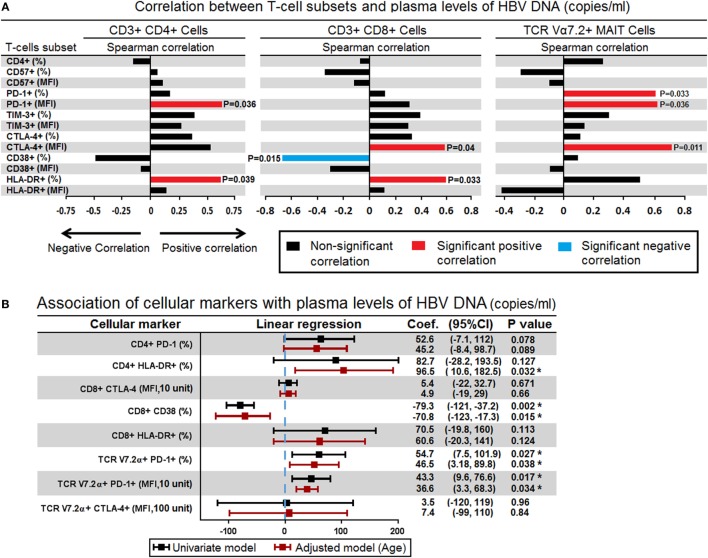
(A) Spearman correlations between surface markers in CD4+ (left panel), CD8+ (middle panel), and mucosal-associated invariant T (MAIT) cells (right panel) with level of plasma hepatitis B virus (HBV)-DNA. The bar represents the strength of association (r values) where red bar represents significant positive correlation, blue bar represent significant negative association and black bar represents P value > 0.05 (non-significant association) (<0.05, **<0.01, ***<0.001, and ****<0.0001). (B) Association of all surface markers that showed significant correlation with plasma HBV-DNA levels were assessed in simple logistic regression model and adjusted for age. Coefficient values below or above threshold levels were displayed in a forest plot; median and 95% CI were calculated. CI, confidence interval (*P < 0.05).